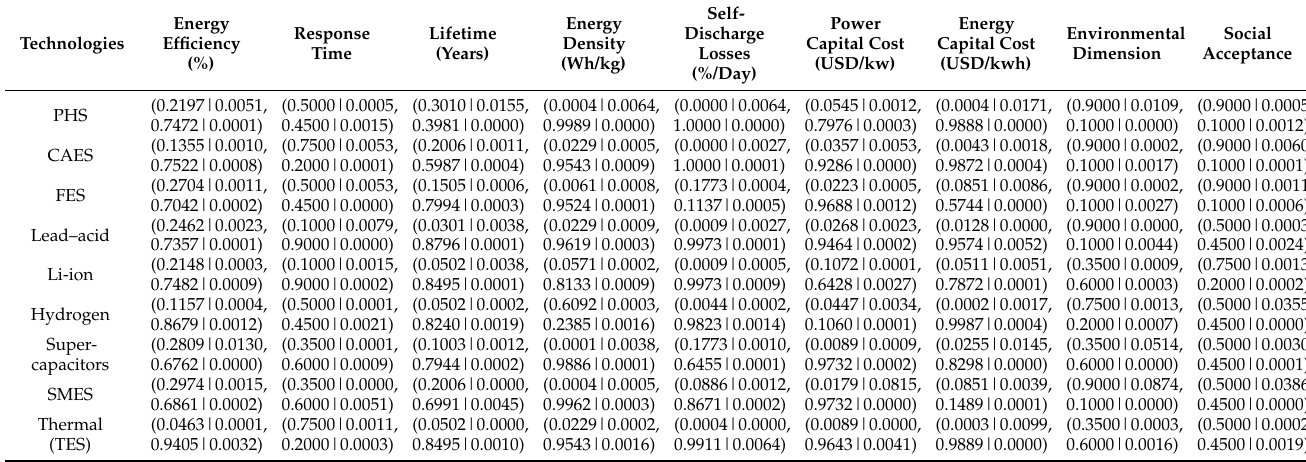
Table A20. The weighted initial decision matrix.